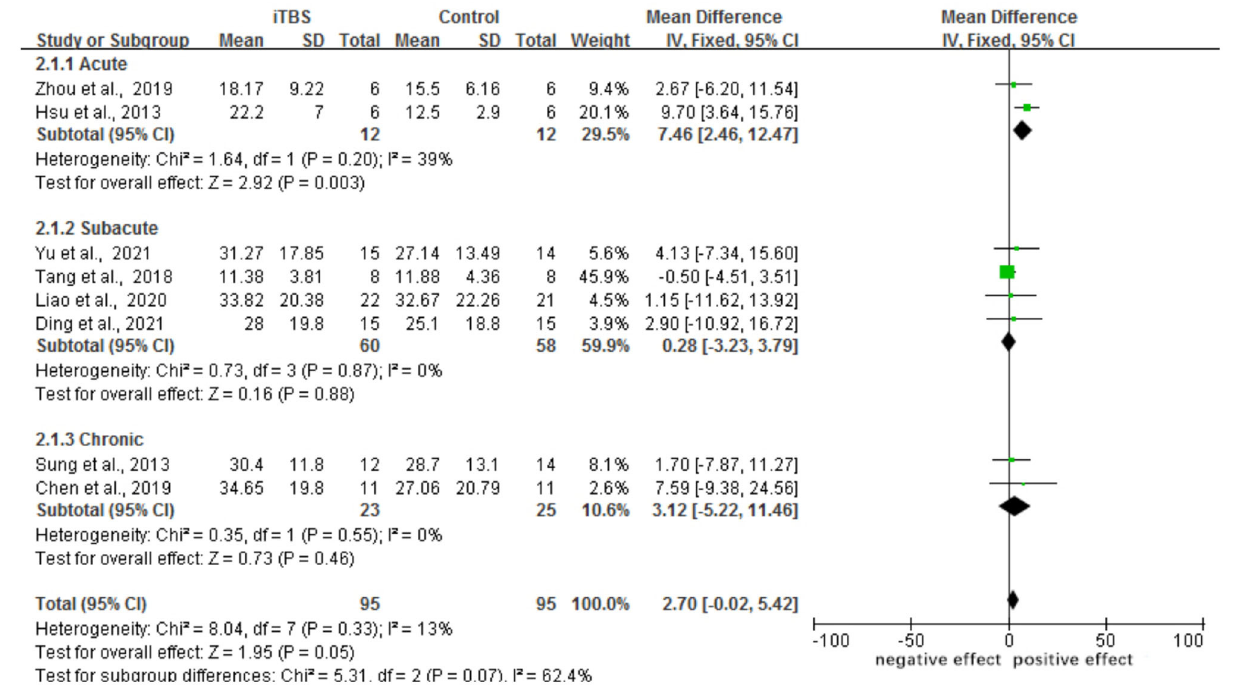
Figure 4 . A funnel plot was used to analyze publication bias. According to reports, if a study’s data falls outside of the 95% range, it is deleted from the funnel plot. The funnel plot appears indicating that there is no publication bias see Figure 5